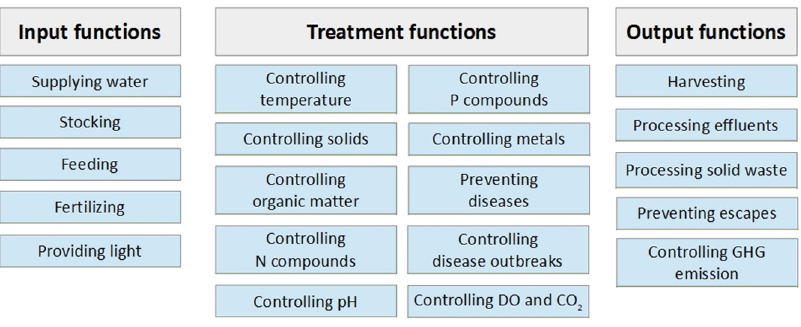
Figure 1. Simplified aquaculture production functions map.